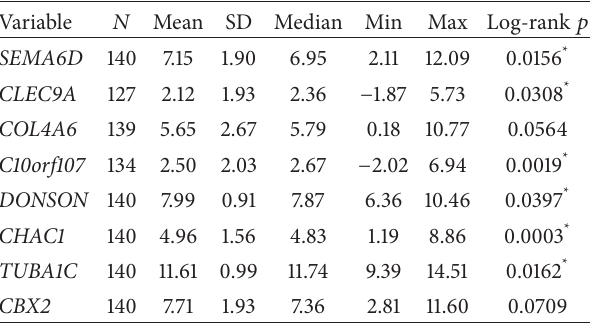
Table 6: Correlation of gene expression with patients’ survival.